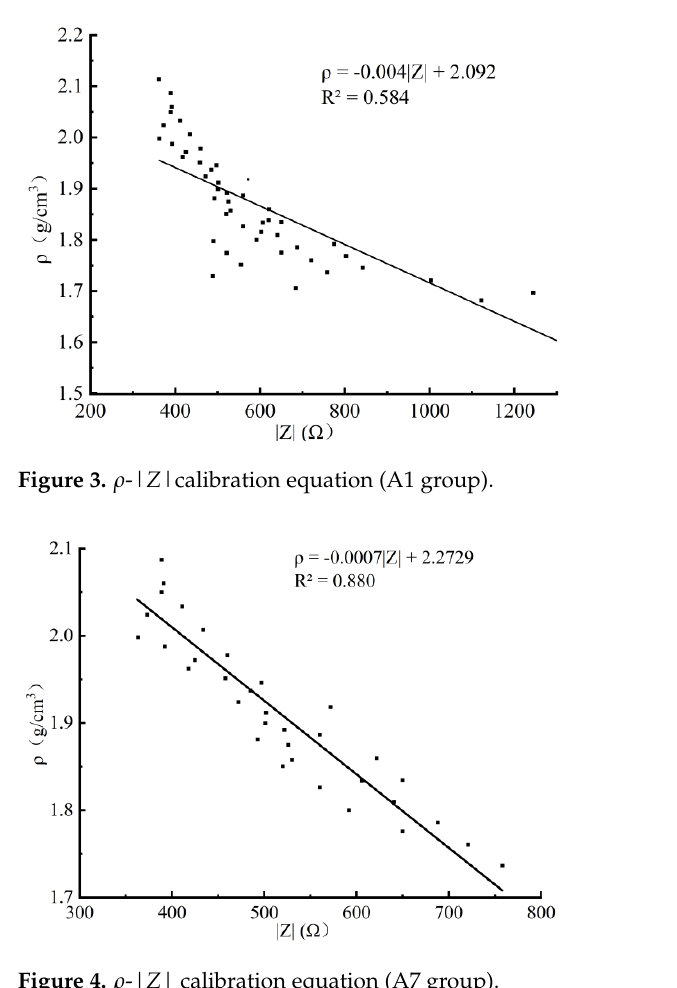
Table 3. Correlation coefficients of calibration equations for soil sample groups with different densities. Group No.